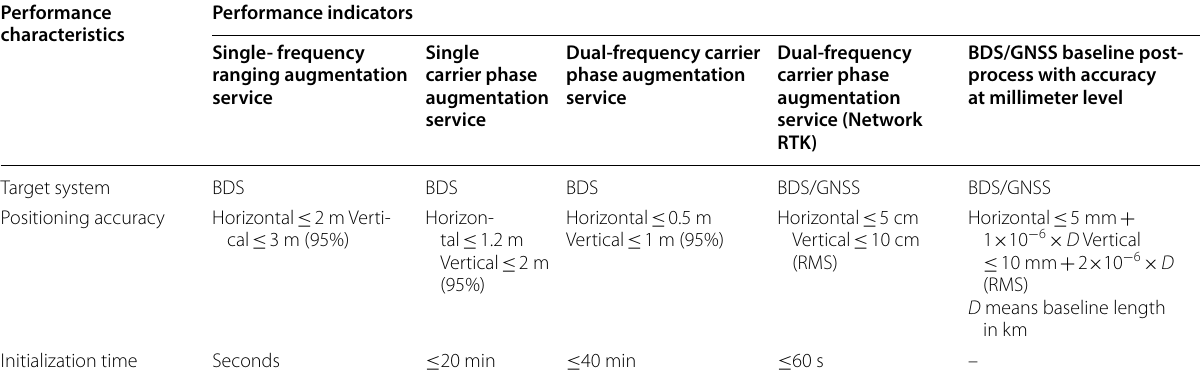
Table 7 Main GAS Service Performance Indicators Performance